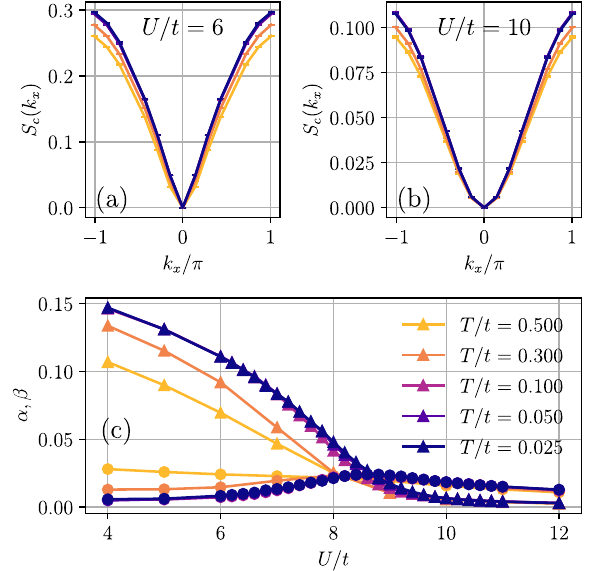
FIG. 2. Static charge structure factor S c ð k Þ for k y ¼ 0 at various temperatures [see legend in (c)] on the 16 × 4 YC4 cylinder from METTS with maximal bond dimension D 4000 . (a) In the metallic regime at U=t ¼ 6 , the density max ¼ structure factor behaves as S c ð k x Þ ≈ α j k x j . (b) In the insulating regime at U=t ¼ 10 , we observe S c ð k x Þ ≈ β k 2 x . (c) Optimal fit parameters α , β for the ansatz S c ð k x Þ ¼ α j k x j þ β k 2 x of S c ð k x Þ close to k x ¼ 0 . α ( β ) is shown as triangles (circles). The crossover interaction strength U c =t can be defined by the intersection of α and β . We observe U c =t shifting toward weaker interactions at higher temperatures.